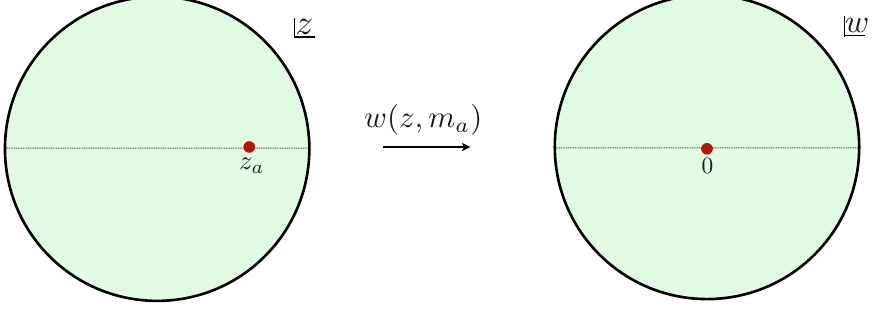
to the unit disk by \opening" the cut and mapping it to z to z = 0, s = to z = 1 and the b 1 (cid:0)